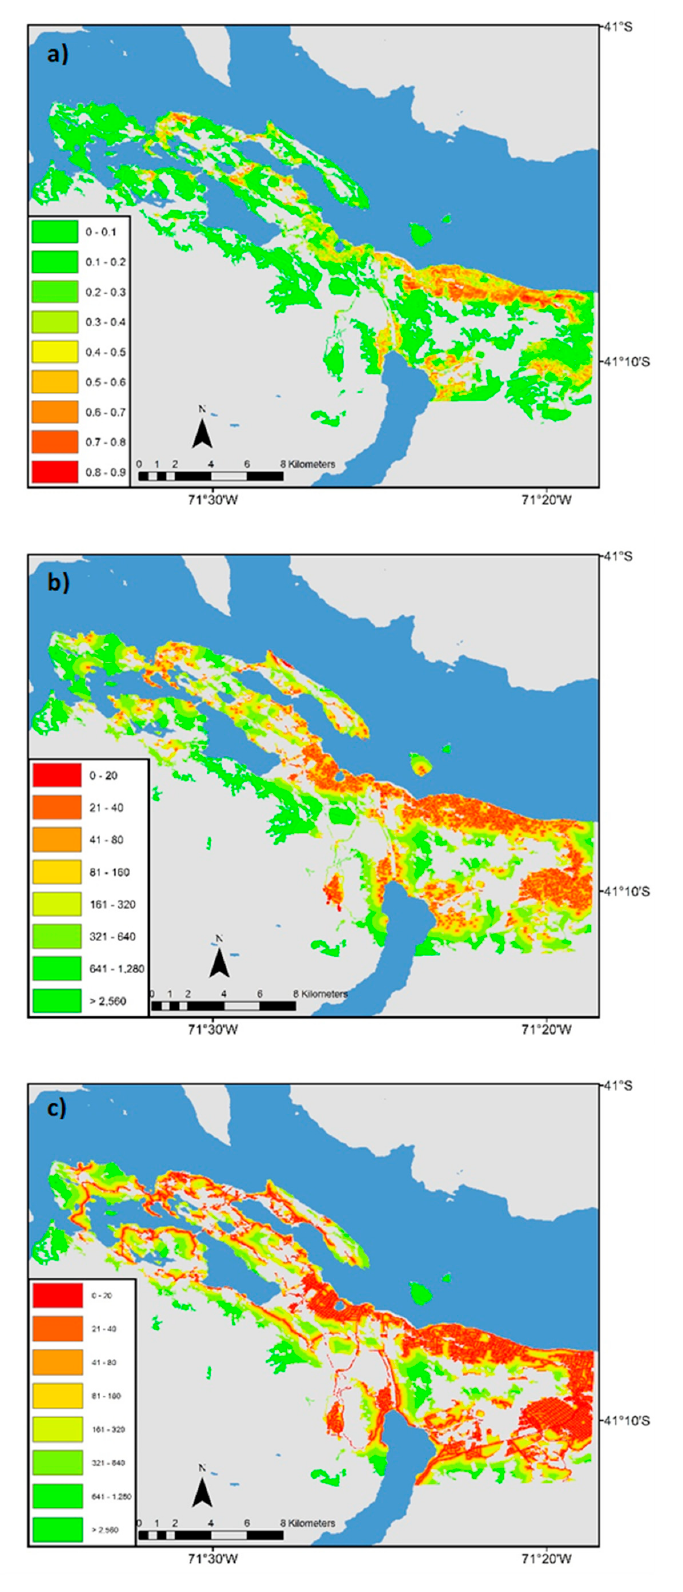
Figure 5. ( a ) Distribution of Austrocedrus disease risk according to MaxEnt model, ( b ) distance to houses (m) and ( c ) distance to roads (m) in San Carlos de Bariloche